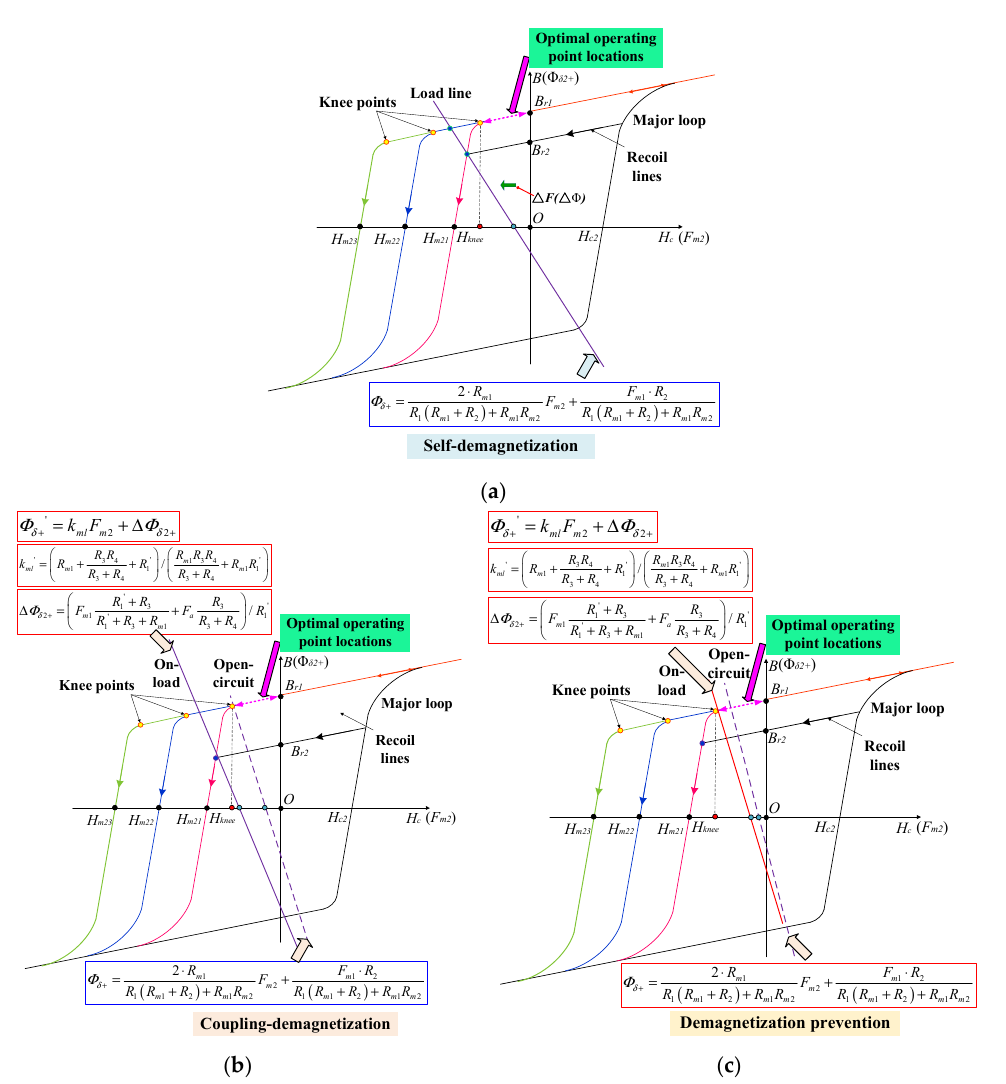
Figure 8. Illustration of the different UD cases by hysteresis curves of LCF PMs with different coercive forces. ( a ) Self-demagnetization. ( b ) On-load coupling demagnetization. ( c ) Prevention of the UD effect.